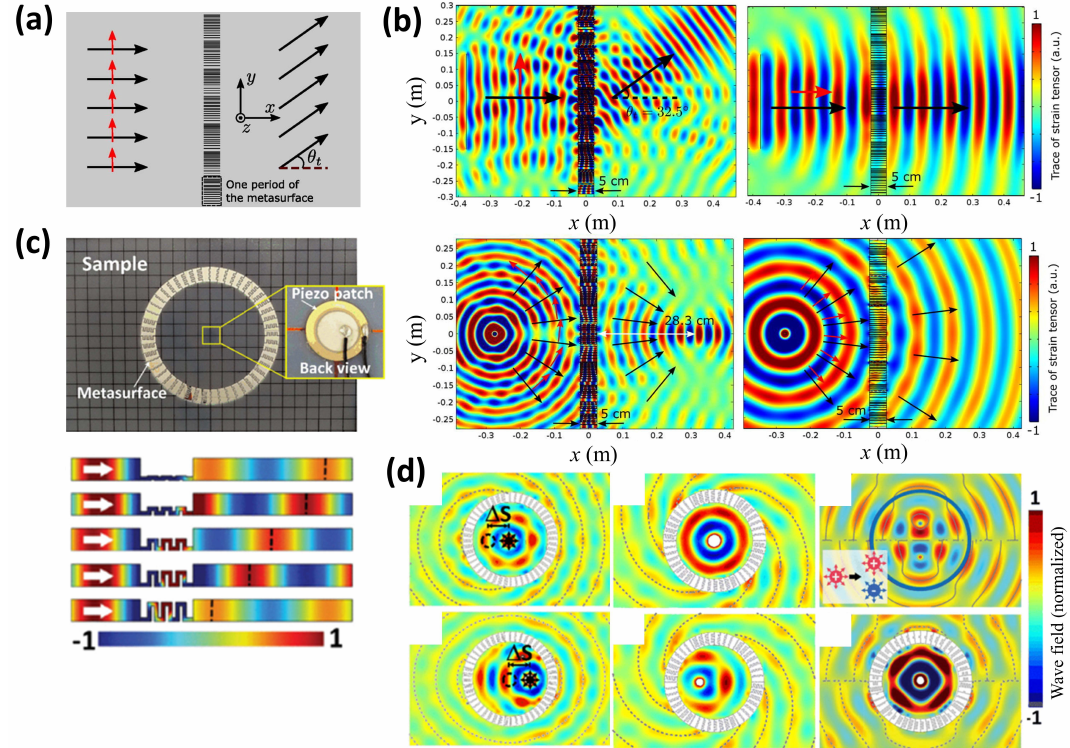
Figure 11. ( a ) Schematic of MS design; ( b ) Left side: the curl of the displacement field showing anomalous refraction of a normal incident SV-wave (upper) and focusing a cylindrical SV-wave source at 60 kHz (lower). Right side: the trace of the strain tensor showing anomalous refraction of a normal incident SV-wave (upper) and cylindrical P-wave incidence (lower) at 60 kHz; ( c ) Schematic of the source shifter (lower) and displacement field produced by different heights h of three zigzag unit cells (upper); ( d ) Left side: Source shifter; the A0 wave field at 12 kHz with the source placed at (0, 0) mm (upper) and (25, 0) mm (lower). Center side: source transformer; the A0 wave field at 8 kHz with the source placed at (0, 0) mm (upper) and ( − 15, 0) mm (lower). Right side: source splitter; the target profile (upper) and the experimentally-measured A0 wave field at 8 kHz (lower). ( a , b ) adapted from [145]. ( c , d ) adapted from